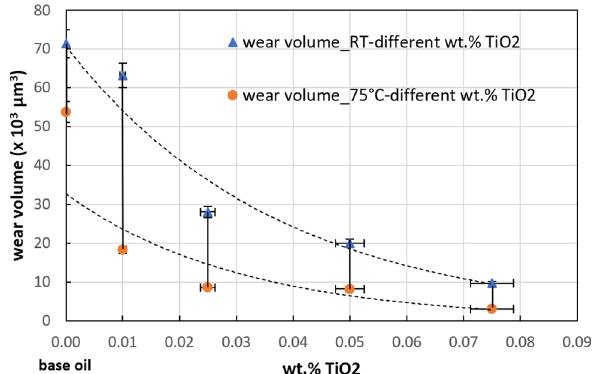
Figure 12. Ball wear volume for oils used in this work at different